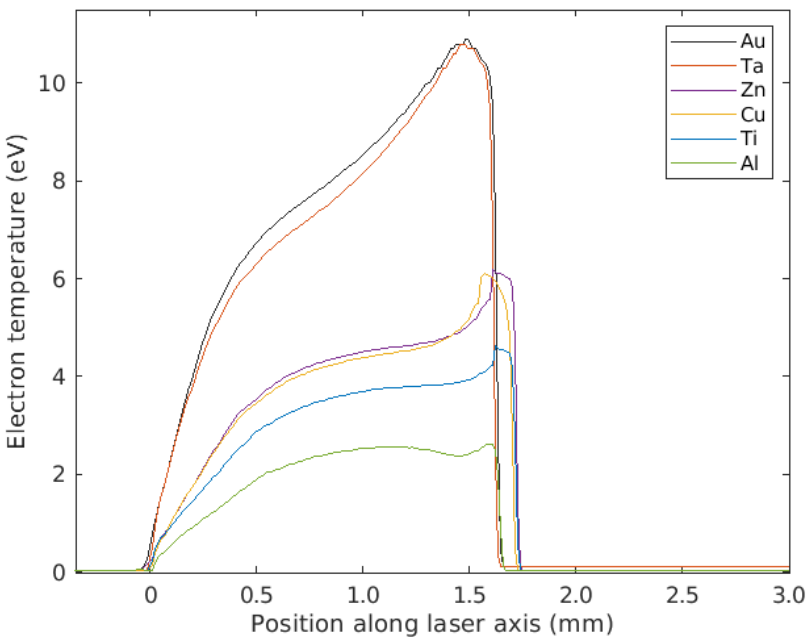
Figure 8. The spatial distribution of the electron temperature of plasma plumes from six different materials, 25 ns after the laser pulse. The laser fluence was 100.5 J cm − 2 and the laser focus was 100 µ